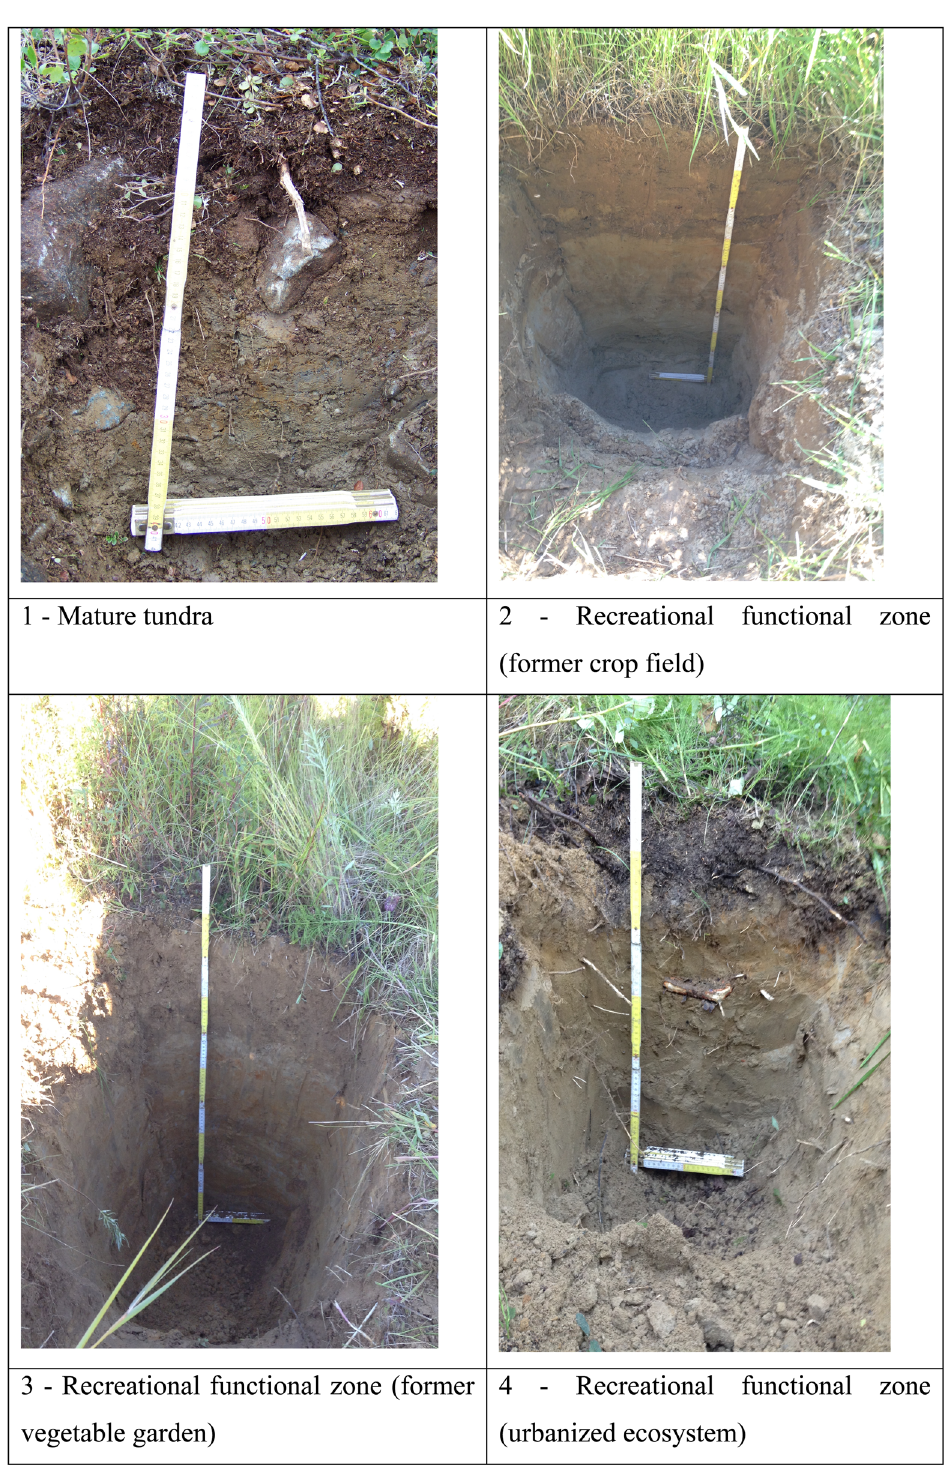
Figure 2: Studied site and respective soil pro fi les ( explanations given in Table 1 )